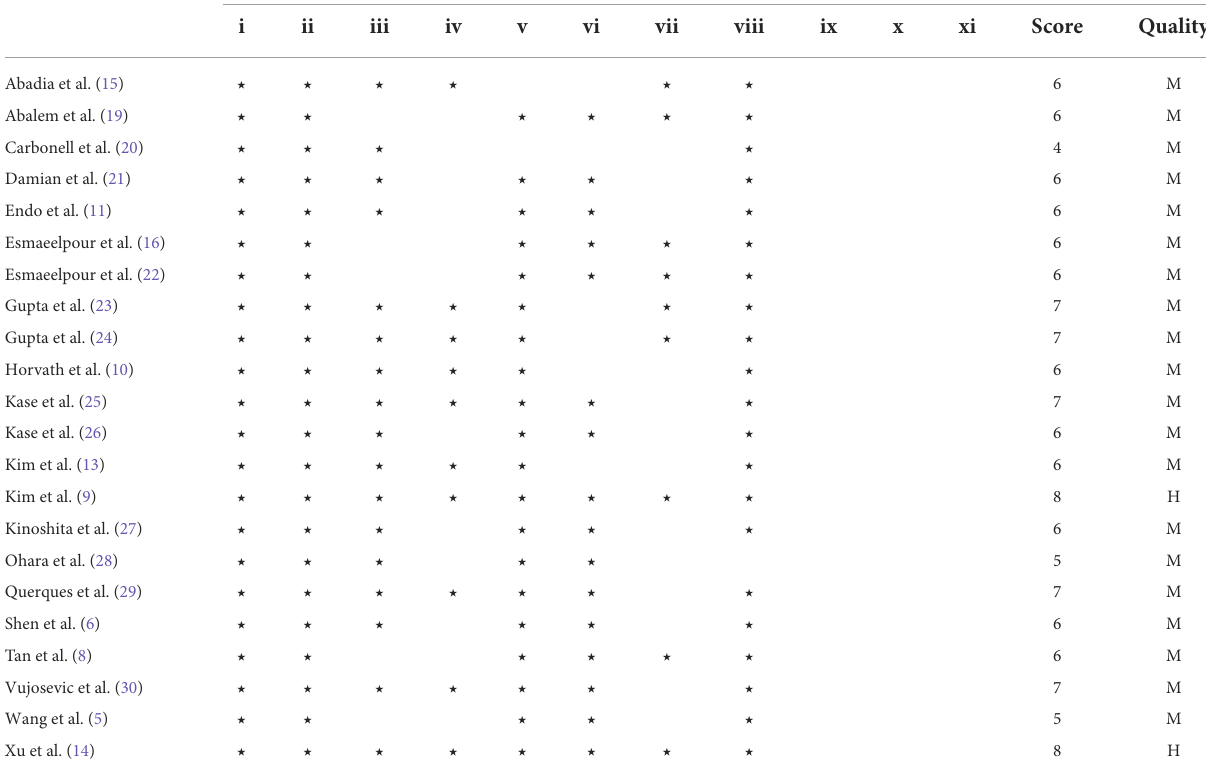
TABLE 2 Methodological quality of included